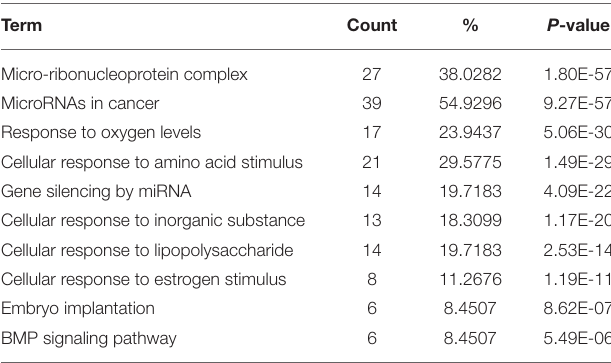
TABLE 3 | The list of changed miRNA functional annotation. TABLE 4 | The list of altered miRNAs predicted target